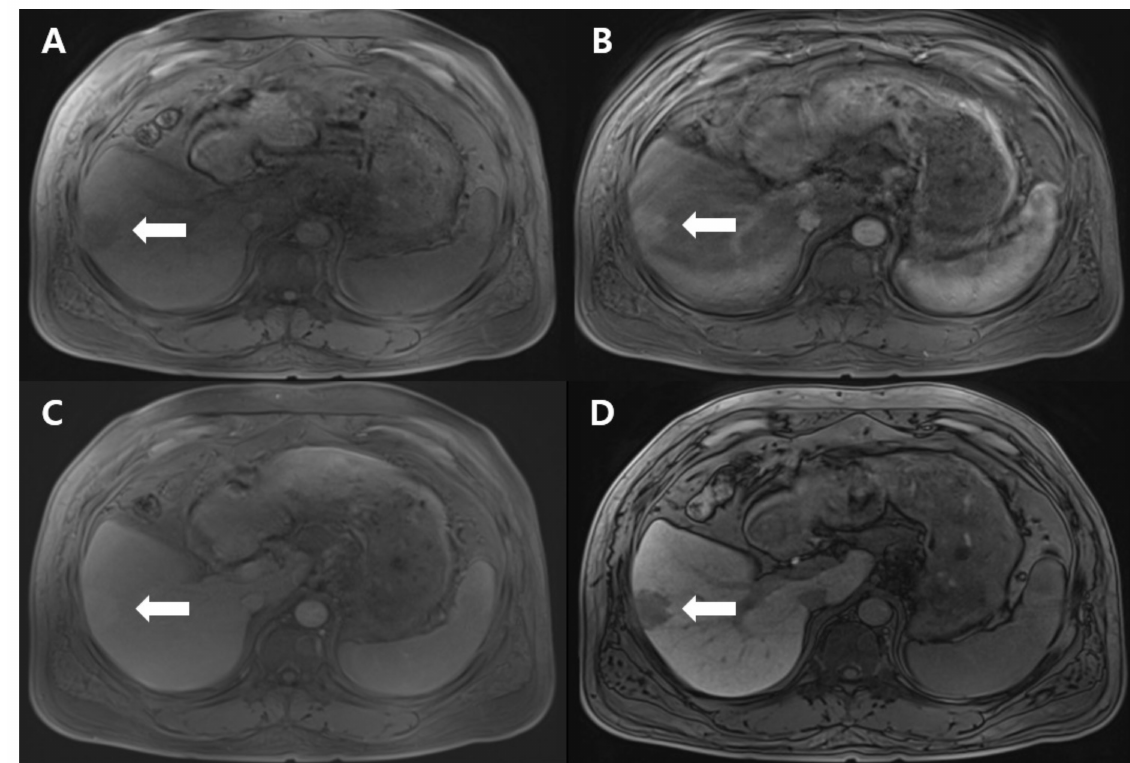
Figure 1. T1-weighted magnetic resonance imaging reveals an approximately 3-cm-sized, lobulated, hypointense mass in the pre-contrast phase ( A ), a hyperintense mass in the arterial phase ( B ), an isointense mass in the delayed phase ( C ), and a hypointense mass in the hepatobiliary phase ( D ), at segment 6. The lesion is indicated by white arrows in all